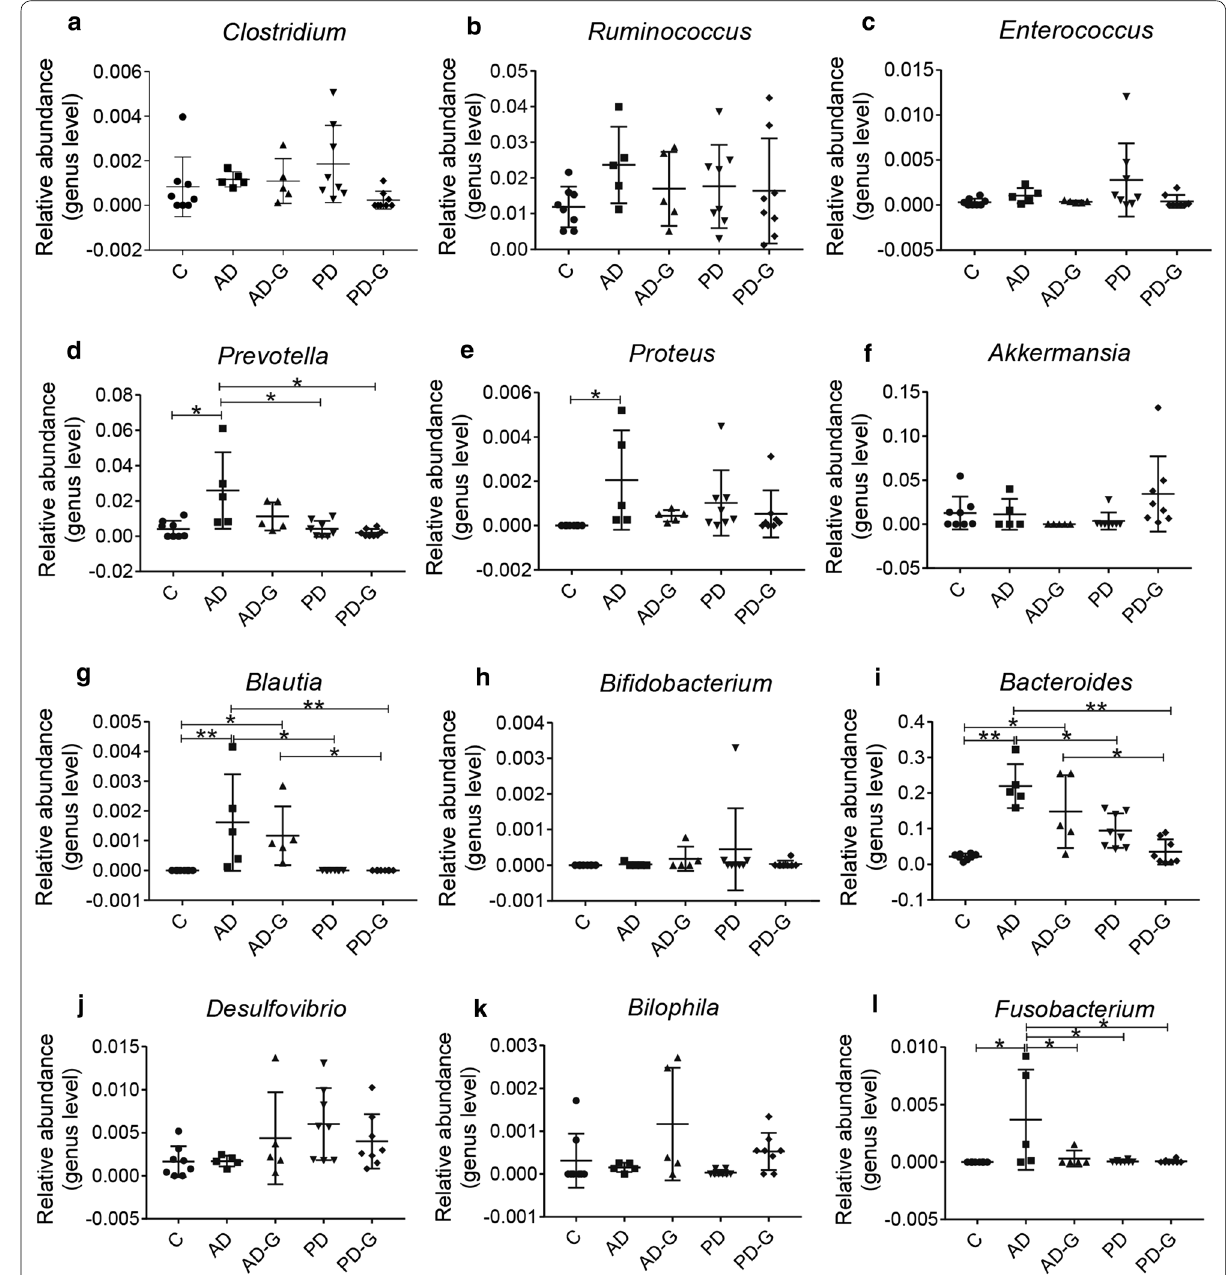
Fig. 6 Effect of the MG1363-pMG36e-GLP-1 on the relative abundance of gut microbial diversity at genus level in feces of mice. The relative abundance of Clostridium ( a ), Ruminococcus ( b ), Enterococcus ( c ), Prevotella ( d ), Proteus ( e ), Akkermansia (f ), Blautia ( g ), Bifidobacterium ( h ) Bacteroides ( i ) Desulfovibrio ( j ) Bilophila ( k ) Fusobacterium ( l ) in feces of mice. C, control group (n 8); AD, LPS group (n 5); AD-G, LPS 10 9 CFU = = + MG1363-pMG36e-GLP-1 group (n 5); PD, MPTP group (n 8); PD-G, MPTP 10 9 CFU MG1363-pMG36e-GLP-1 group (n 8). Data are presented as = = + = mean SD. *p < 0.05, **p < ±